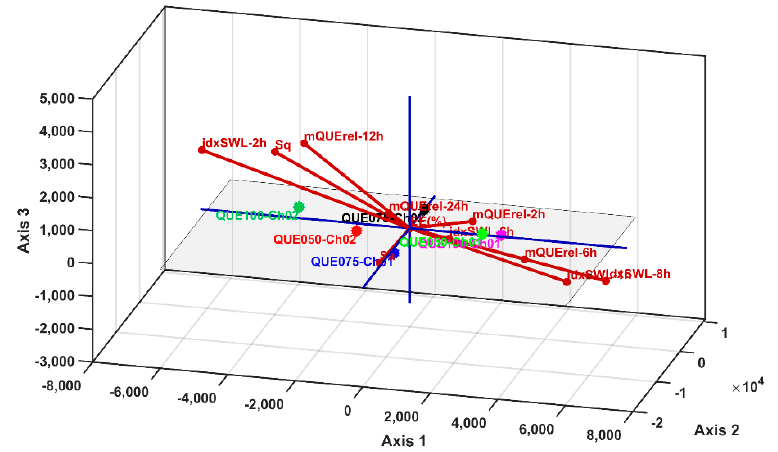
Figure 21. Biplot of LDA results in 3D representation for Axis1, Axis2 and Axis3 canonical compo- nents.